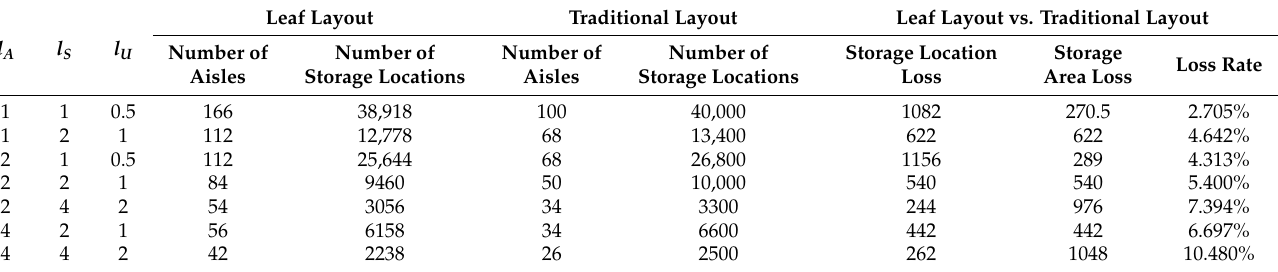
Table 12. Storage loss of the leaf layout.